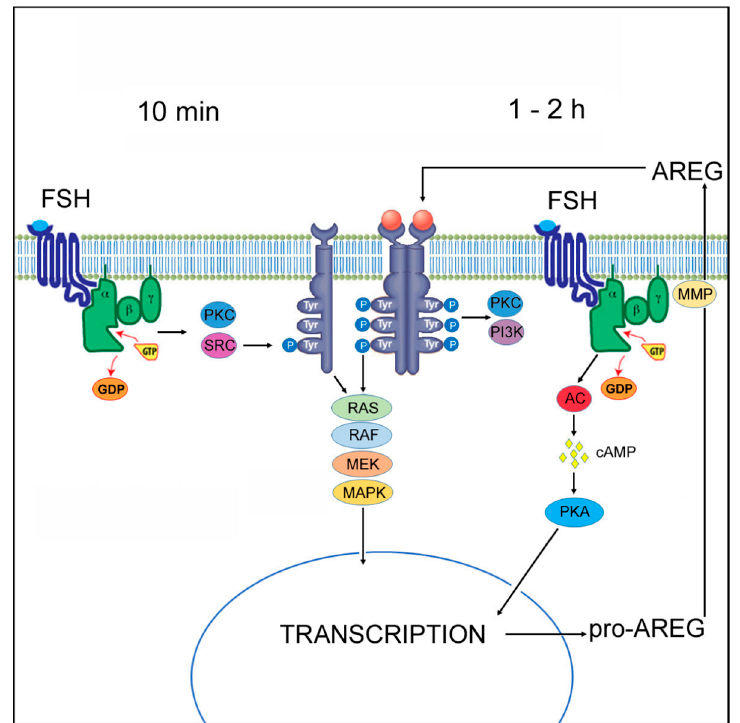
Figure 4. Ligand-independent and ligand-dependent transactivation of epidermal growth factor receptor (EGFR)/MAPK3/1 pathway in pig cumulus cells by FSH. The binding of FSH to the G q class of G-protein coupled receptors (GPCRs) results in the activation of protein kinase C (PKC) and SRC that phosphorylates EGFR in its intracellular domain. It is not clear whether this phosphorylation leads to receptor dimerization [26]. The SRC-mediated phosphorylation is associated with activation of the RAS/RAF/MEK1 pathway and rapid activation of MAPK3/1, but it may not lead to full phosphorylation of the intracellular domain and activation of all pathways known to be associated with EGFR TK activity [31,32]. FSH also binds to the G s class of GPCRs and activates adenylyl cyclase, which leads to an increase in cAMP and activation of PKA. This PKA activity is required for the synthesis of the AREG pro-peptides [13], which are cleaved at the plasma level by TACE/ADAMs metalloproteinases and released outside the cumulus cells into the extracellular space. The active forms of AREG serve as ligands for EGFR, which leads to dimerization of the receptor, full phosphorylation of its intracellular domain and activation of downstream signaling pathways, including the MAPK3/1, PKC and PI3K pathways. The transcription- and ligand synthesis-dependent process of EGFR/MAPK3/1 activation requires 1–2 h to be activated [13] and operates in cumulus cells for an extended period of time. MAPK3/1 may thus be involved in events occurring in minutes after the exposure of follicular cells to gonadotropins, such as gap junction closure through connexin phosphorylation [15] and the regulation of cGMP level in follicular cells [41–43], as well as in delayed events such as the regulation of steroidogenesis and cumulus expansion [20]. MEK: MEK1/2; MAPK: MAPK3/1; MMP: matrix metalloproteinases; AC: adenylyl cyclase.